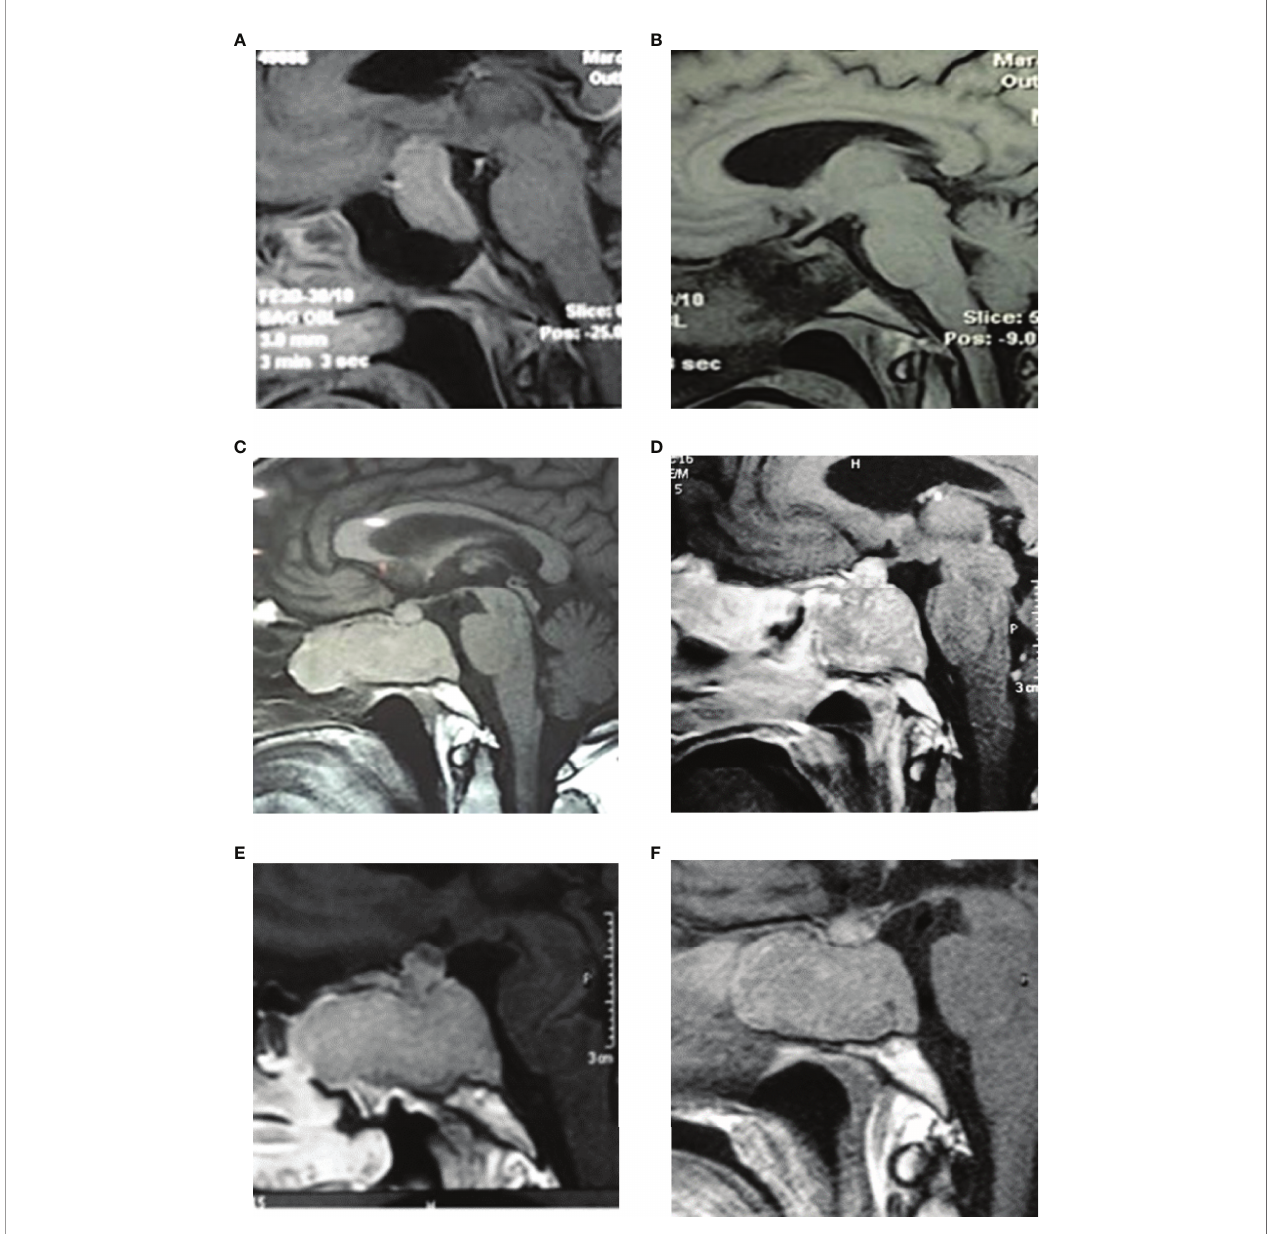
FIGURE 2 | MRI images. (A) 2008-Preoperative pituitary MRI with gadolinium (sagittal view), evidencing a large pituitary mass with suprasellar extension and compression of the optic chiasm. (B) Postoperative MRI with gadolinium (sagittal view) showing complete tumor resection and decompression of the optic chiasm. (C) 2014-pituitary MRI (sagittal view) evidencing a tumor mass with extensive sphenoid and nasal invasion. (D) Postoperative MRI with gadolinium (sagittal image) showing partial resection with a remnant tumor in the nasal, sphenoid, and sellar region. (E) Control MRI in 2015 shows tumor regrowth in the sagittal image. (F) Postoperative MRI (sagittal view) showing less remnant tumor mass than in 2015. Tumor remains stable after radiotherapy and both cabergoline and ketoconazole treatment until